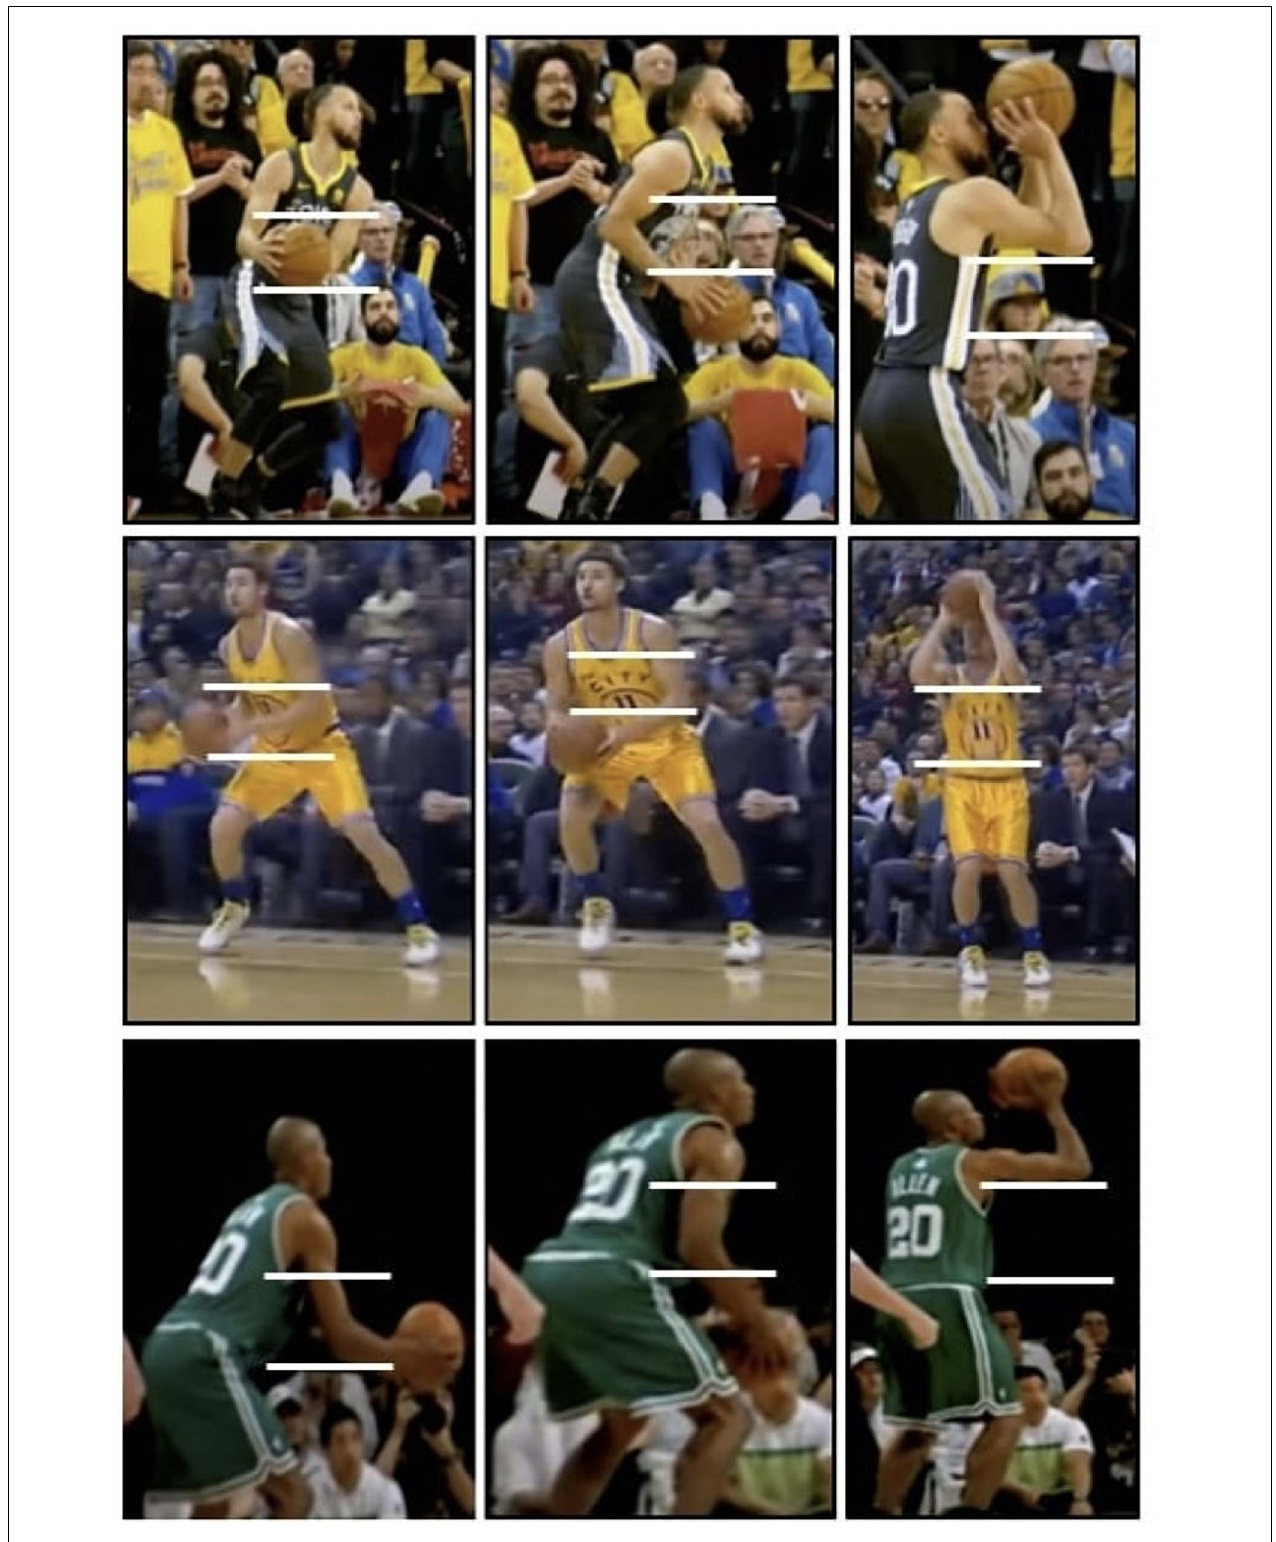
FIGURE 1 | Demonstration of Elite Shooters Steph Curry, Klay Thompson, and Ray Allen “dipping” the basketball after catching the ball off a pass; the ball is caught in the “shot pocket” (indicated by white lines), lowered below it prior to raising the ball to the “set point,” and shooting the ball (the “dip”) (ShotMechanics, 2014; Splash Lab, 2016; Basketball Tips Shotur,